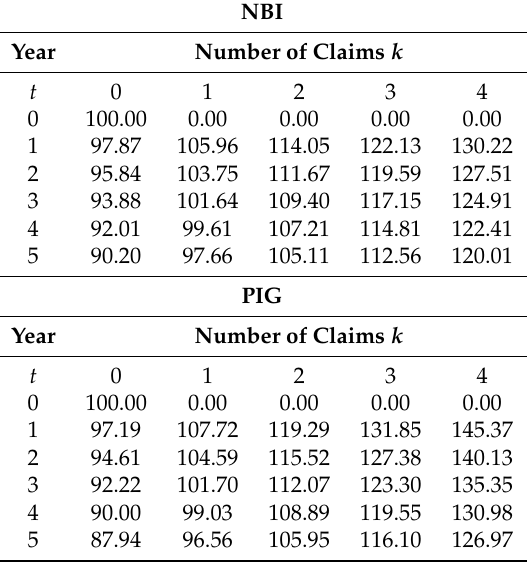
Table 10. A Posteriori, or Bonus-Malus, premiums for risk class 4, regression models with varying